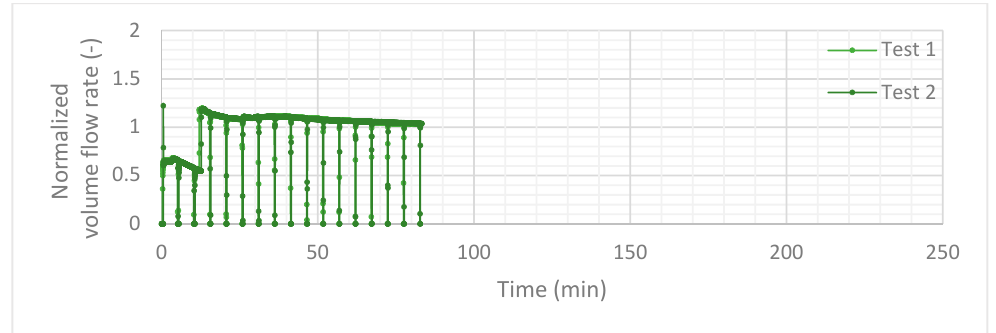
Figure A7. Normalized air volume flow rate trend at a thermostatic temperature of − 20 °C during the two repetitions.